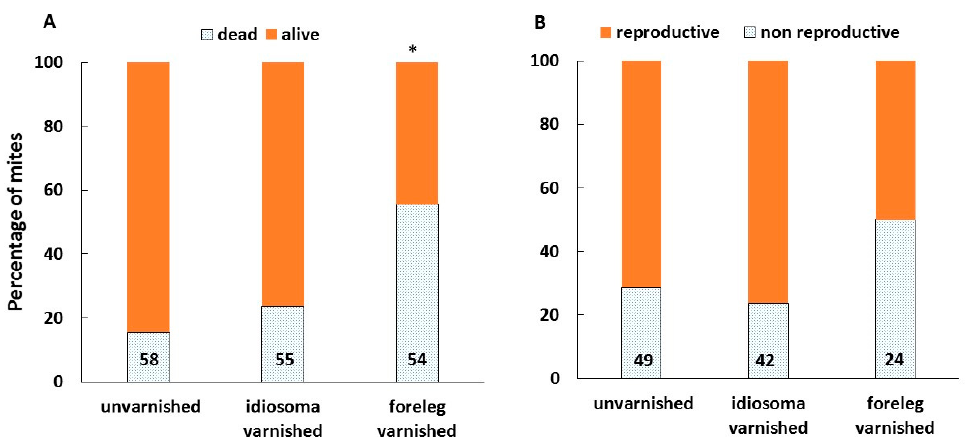
Figure 5. The effect of treatments on the rate of survival ( A ) and reproduction of mites ( B ) in artificially infested brood cells. Numbers at the bottom of bars indicate the total number of mites for each treatment. *—indicates bar that is significantly different from the other two, Chi-Square, p < 0.0001.